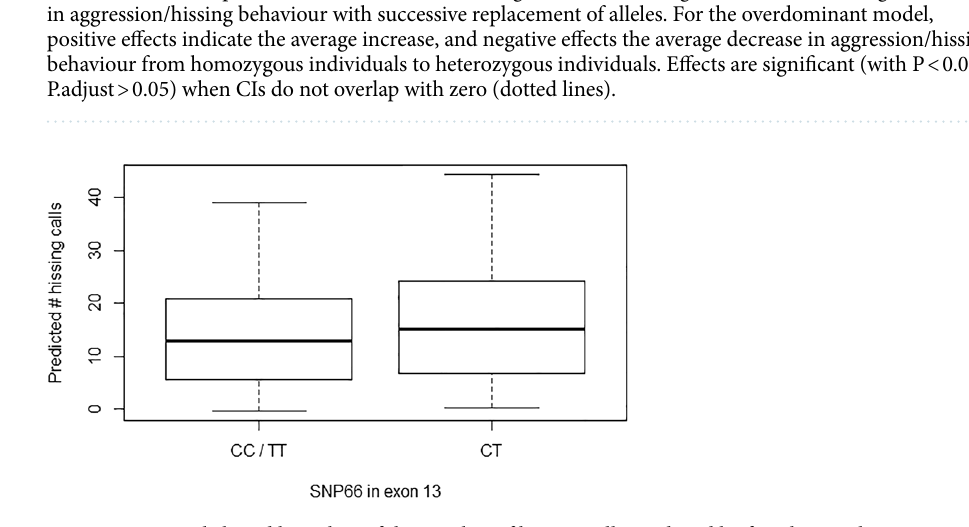
Figure 2. Quartile based box plots of the number of hissing calls produced by females in relation to exon 13 SNP66 genotype. Plotted are the number of hissing calls corrected for fixed and random effects included in the overdominant effect model (i.e. predicted values; see text for details). For illustration purposes, the estimates from the model with standardized hissing calls were back-transformed to the actual number of hissing calls produced. N females per genotype: CC/TT: 186, CT: